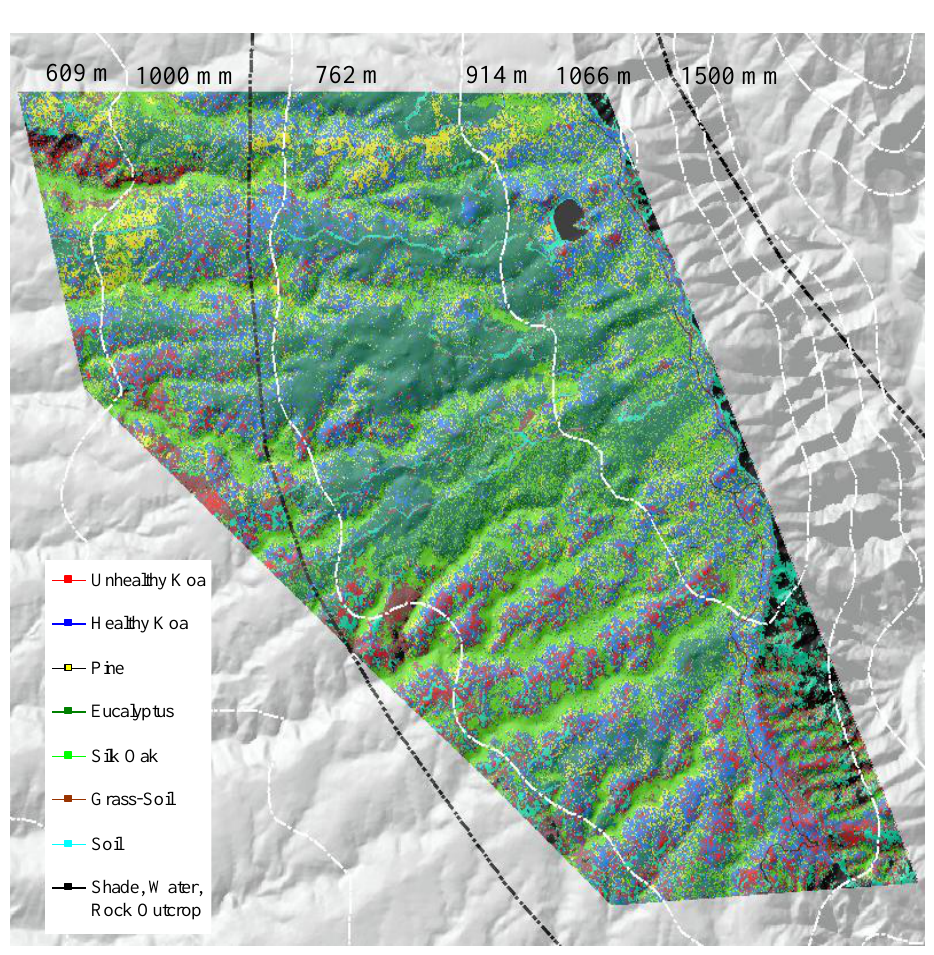
Figure 4. Image classification of the entire elevation gradient overlaid on a digital elevation model 3D surface view. Black lines represent isohyets in millimeters of rainfall and white lines are elevation contours in